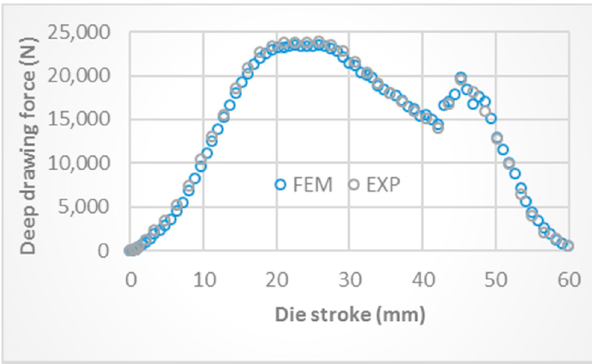
Figure 7. Comparison of deep drawing force between FEM simulation and experimental results (DR: 2.25; Ø initial blank: 90 mm).